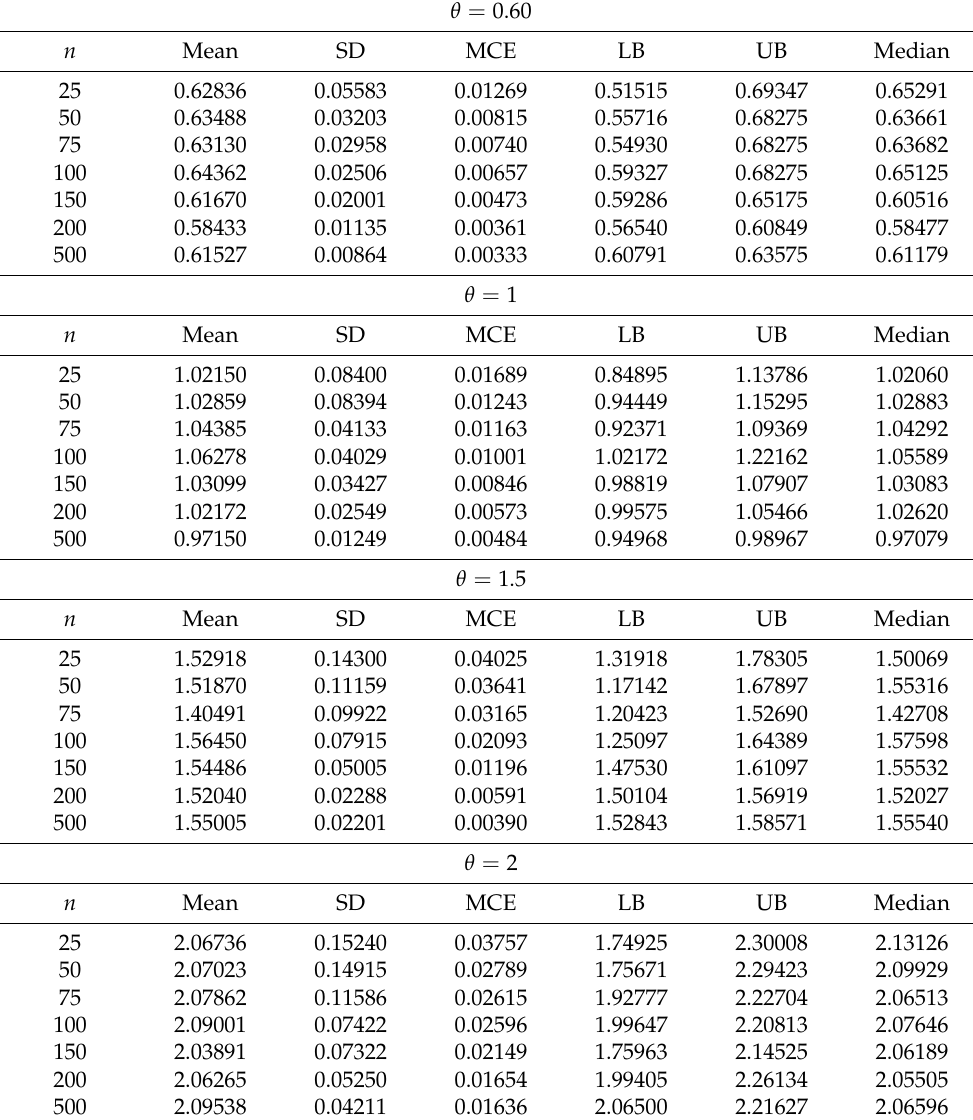
Table 5. Posterior summary results (Case 2: θ ∼ N ( 0,1000 ) ).